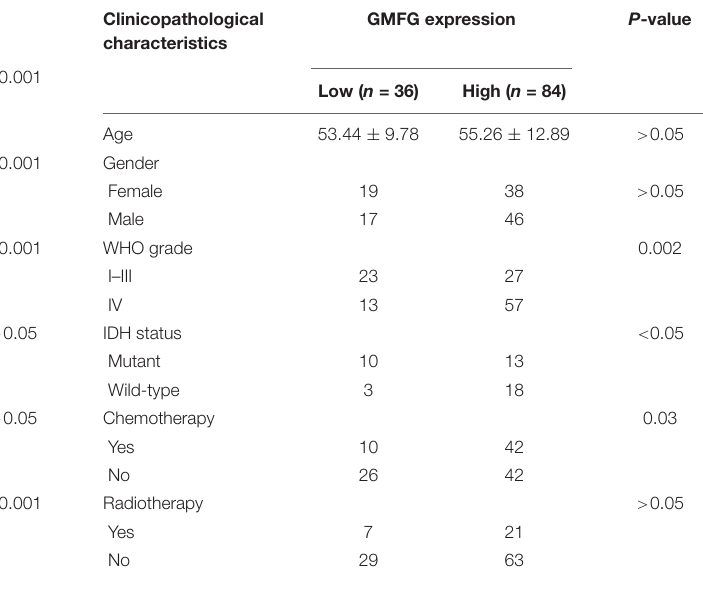
TABLE 2 | Correlation between GMFG and clinicopathological characteristics in patients with gliomas in in-house cohort. Clinicopathological